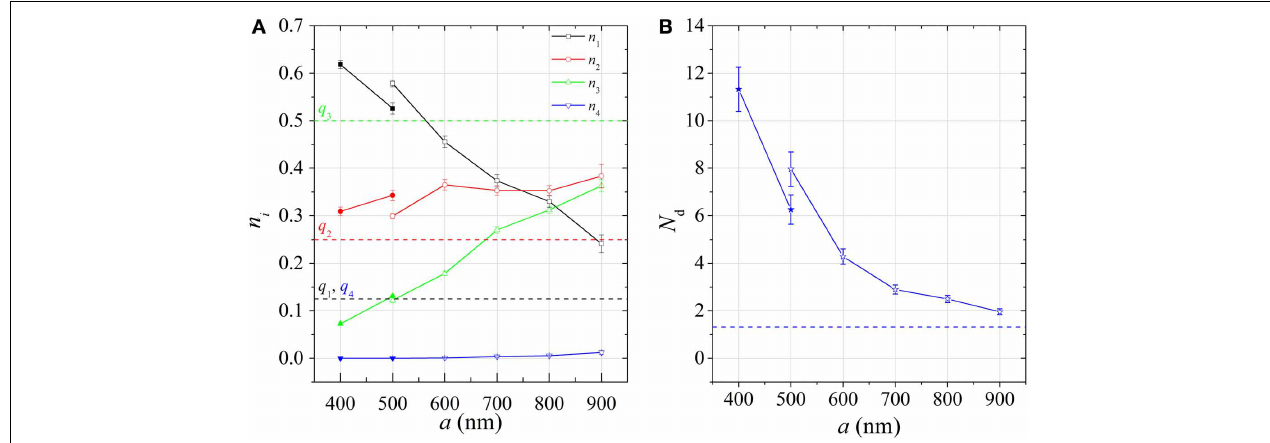
FIGURE 4 | (A) Vertex populations n i for i = 1–4 vs. lattice constant a . Dashed lines represent the corresponding random-state values, as given by multiplicities q i . (B) The corresponding mean areal domain size N d . Data points for batch 1(2) are